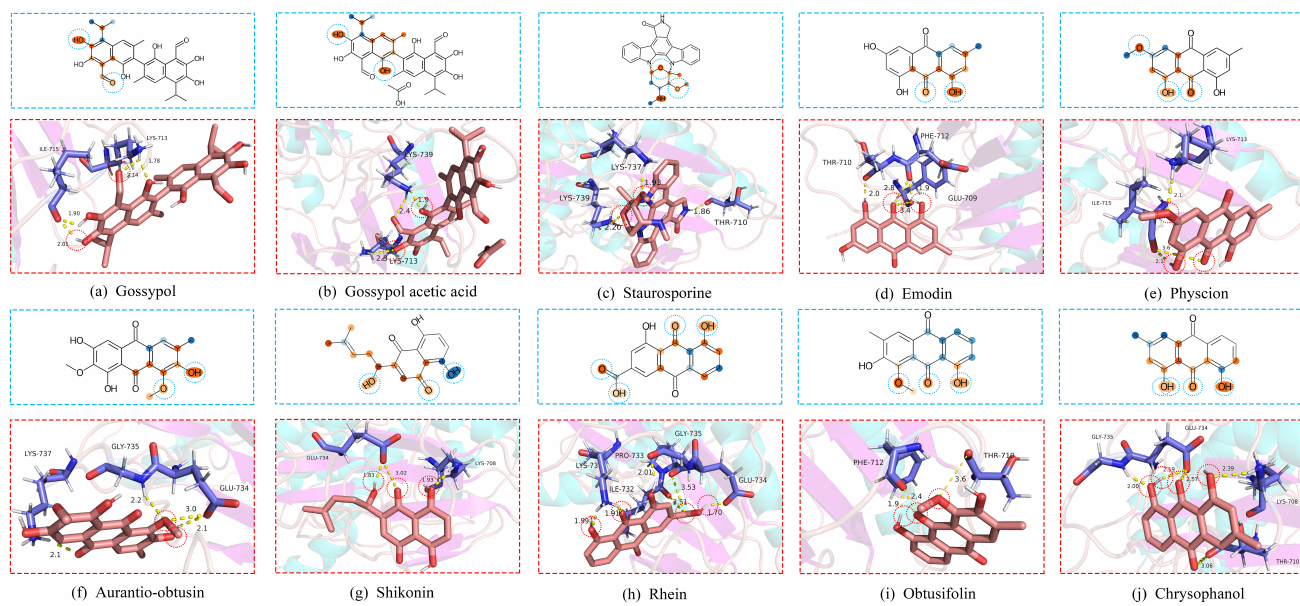
Figure 4. The blue box shows the heatmaps of atomic contributions. In the red box, are molecular docking poses of the top 10 natural drugs with EGFR T 790 M mutant